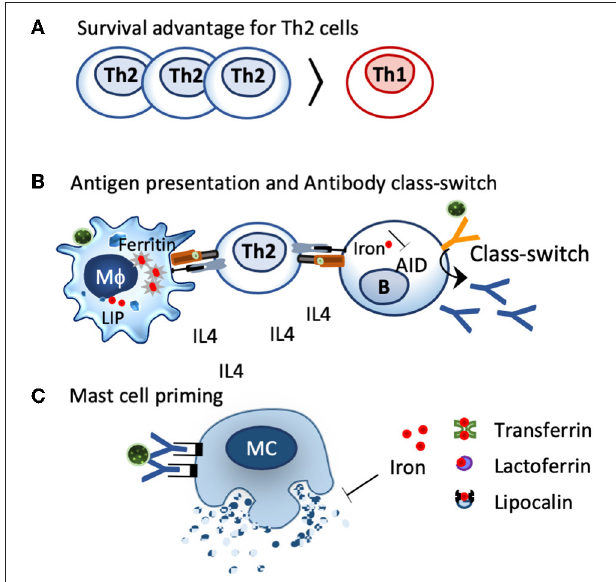
FIGURE 3 | Impact of iron deficiency on immune cells. (A) . Th2 cells characterized by IL4 secretion have a greater chelatable iron pool compared to Th1 cells and have a survival advantage under iron-deficient conditions. (B) . Iron-deficient conditions modulate iron handling in macrophages and shift them towards a more activated, inflammatory status, which facilates antigen presentation. The activation-induced cytidine deaminase (AID), an